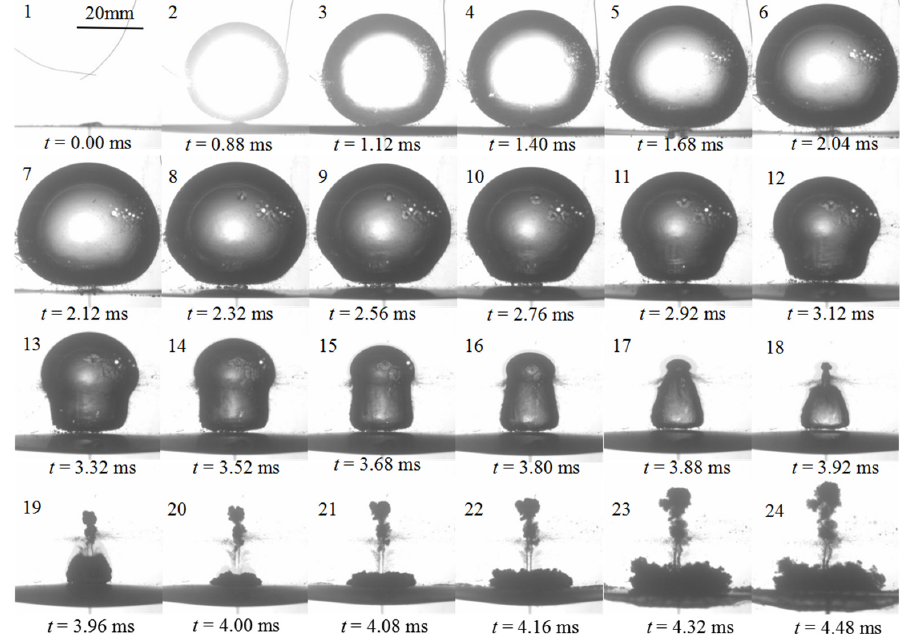
γ = 0.81 and R = 19.4 m